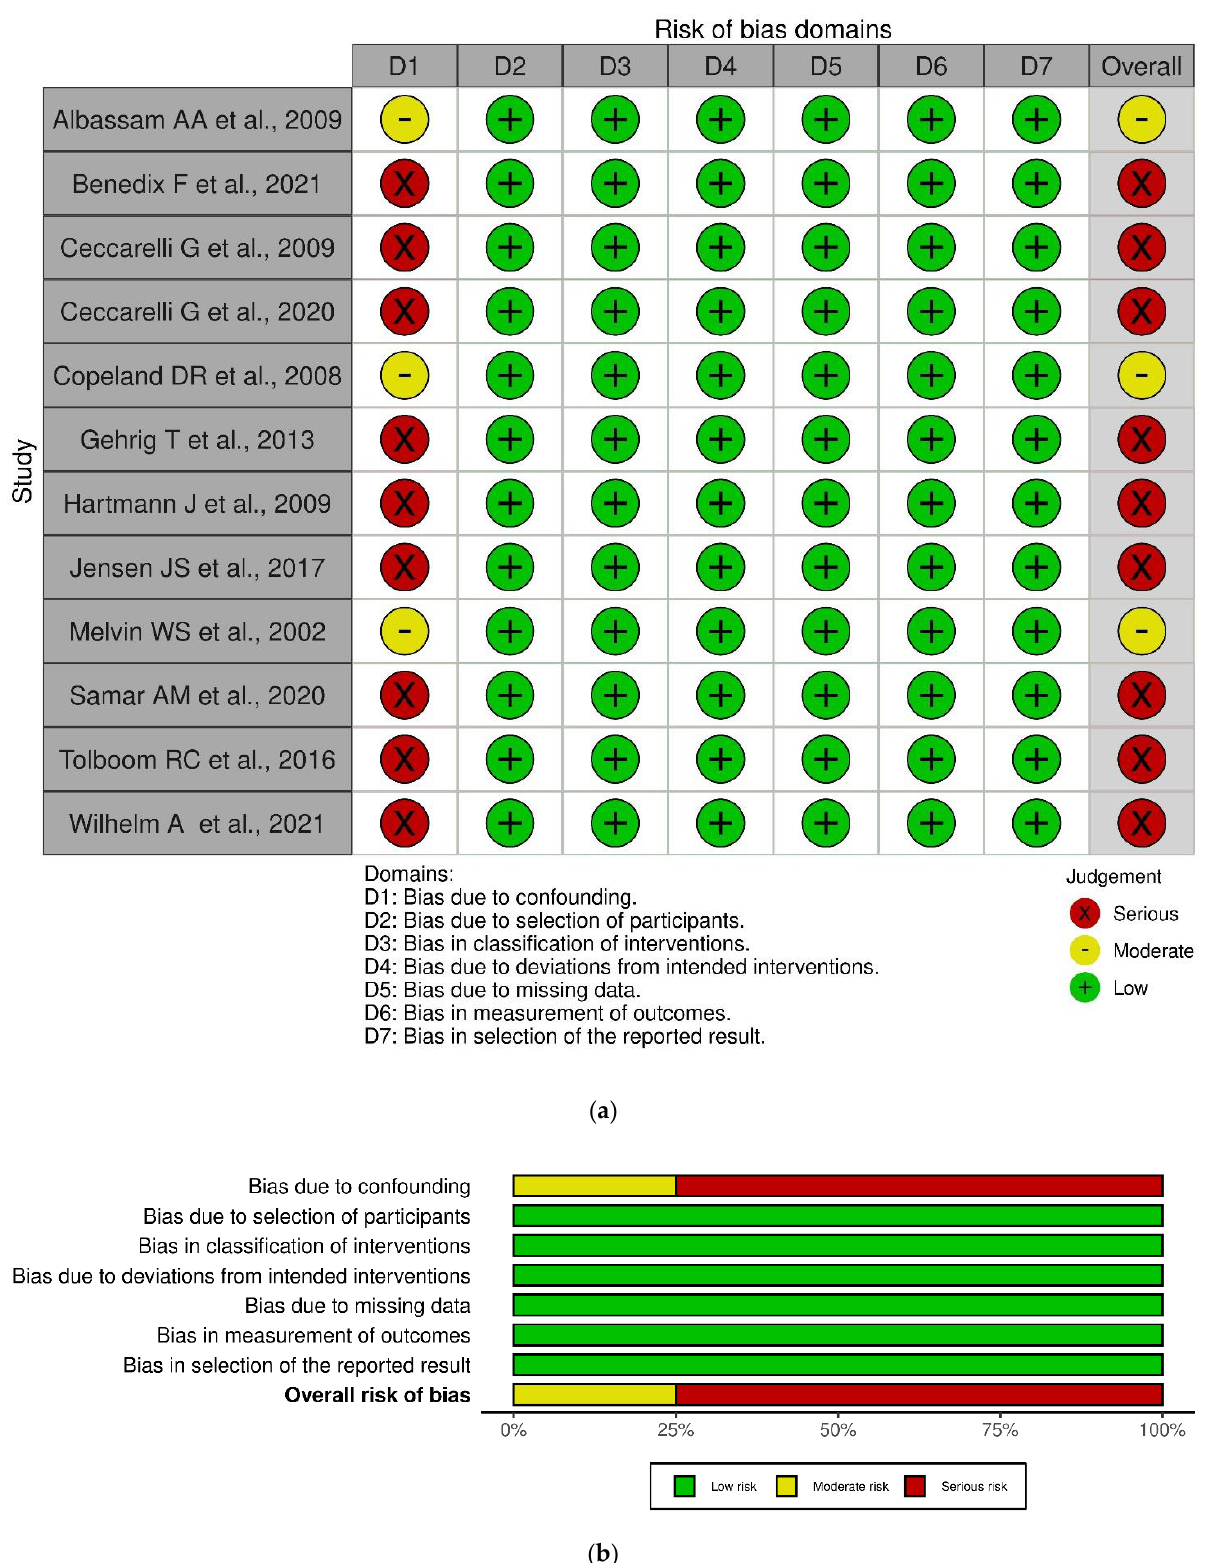
Figure 3. Summary of risk of bias for non-RCT studies [22 – 26,28 – 31,35 – 37]